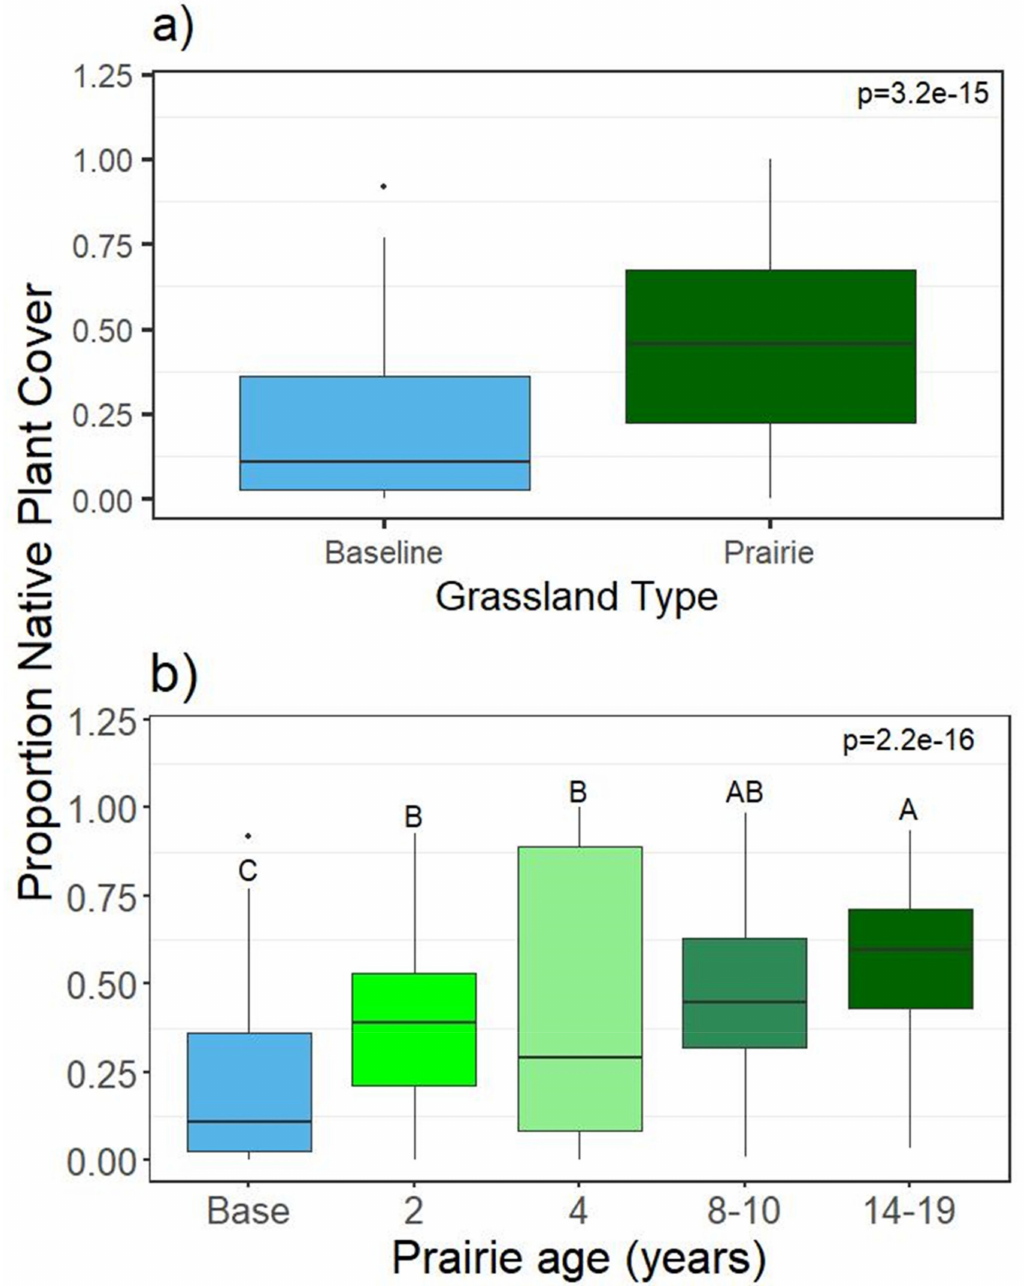
Figure 3. Average proportion of native plant cover in grasslands in 2018, shown by ( a ) grassland type and ( b ) prairie age. Di ff erent letters indicate statistical di ff erences between treatments ( p < 0.05). NP = baseline (not planted to prairie: cool